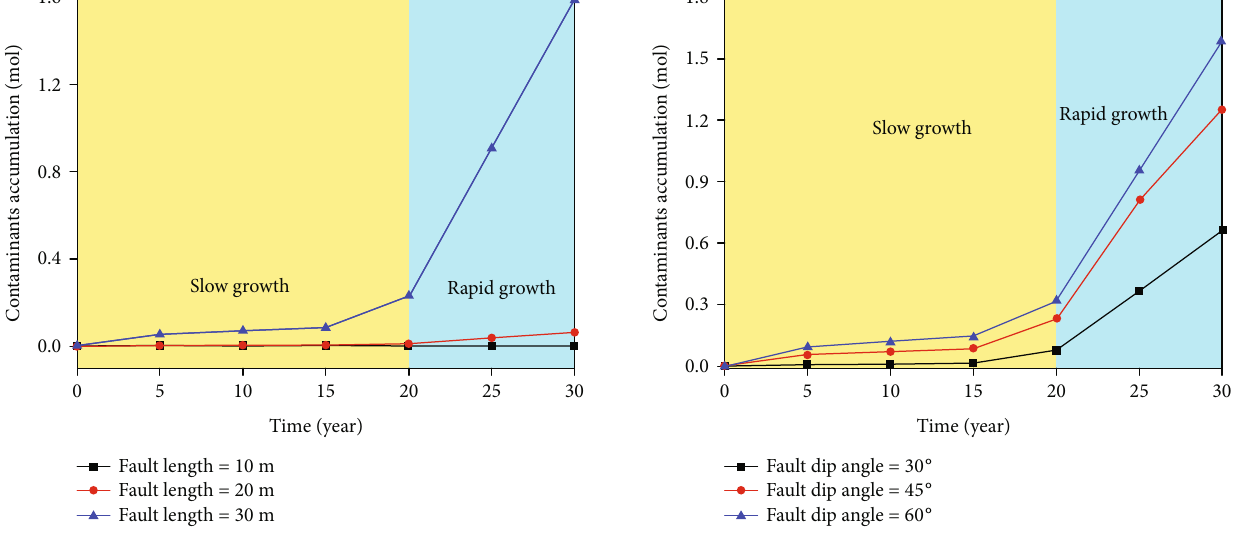
Figure 13: The contaminant accumulation along the line of CD under di ff erent fault lengths. Table 3: The fault width in the di ff erent models. Model no.